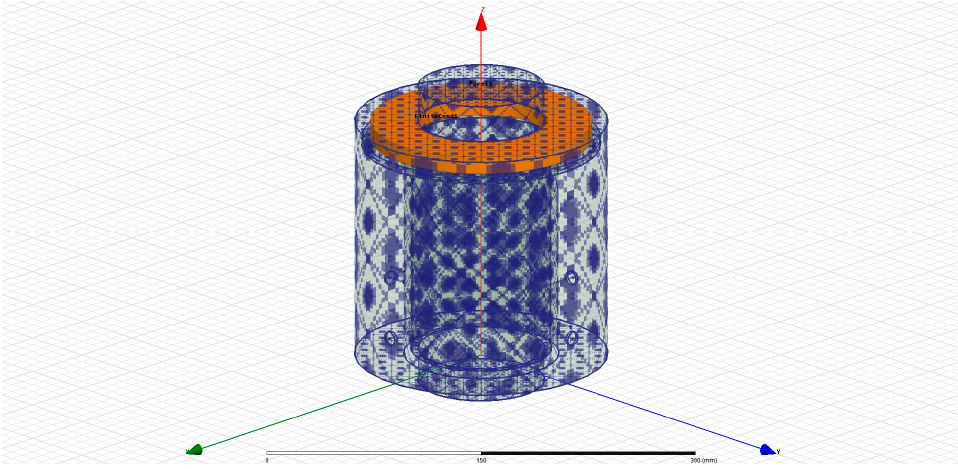
Figure A1. Finite conductivity and perfect E applied across the model faces.